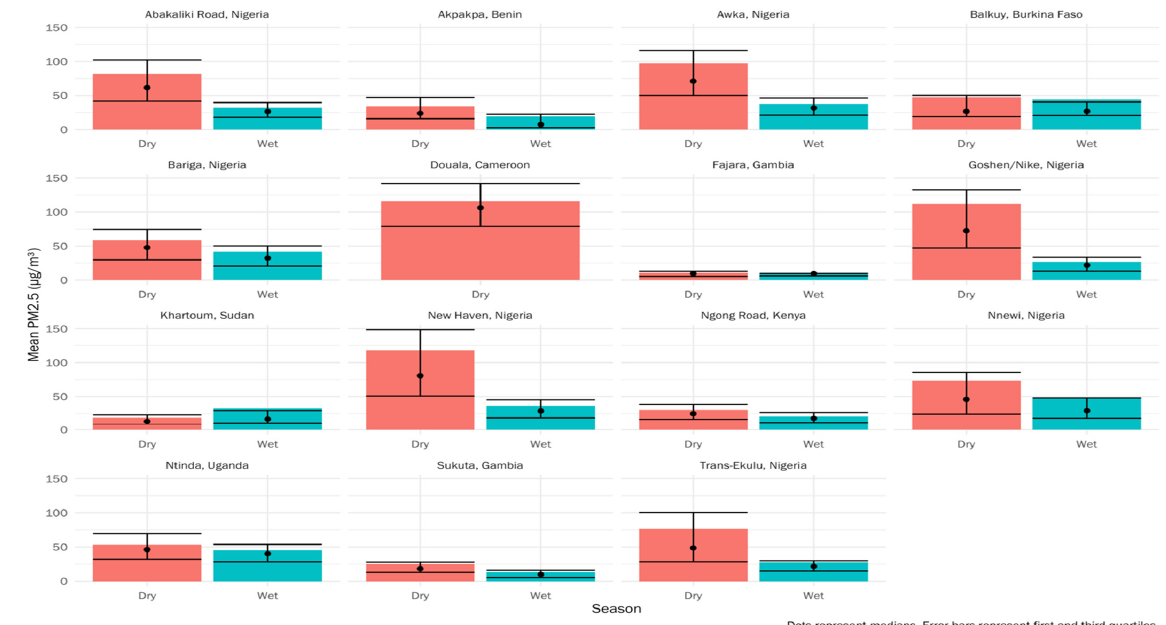
Figure 4. Seasonal PM 2.5 means, medians and quartiles by site.